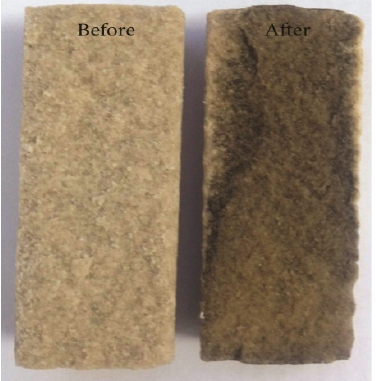
Figure 10. Image of the core profile before and after flooding [152].